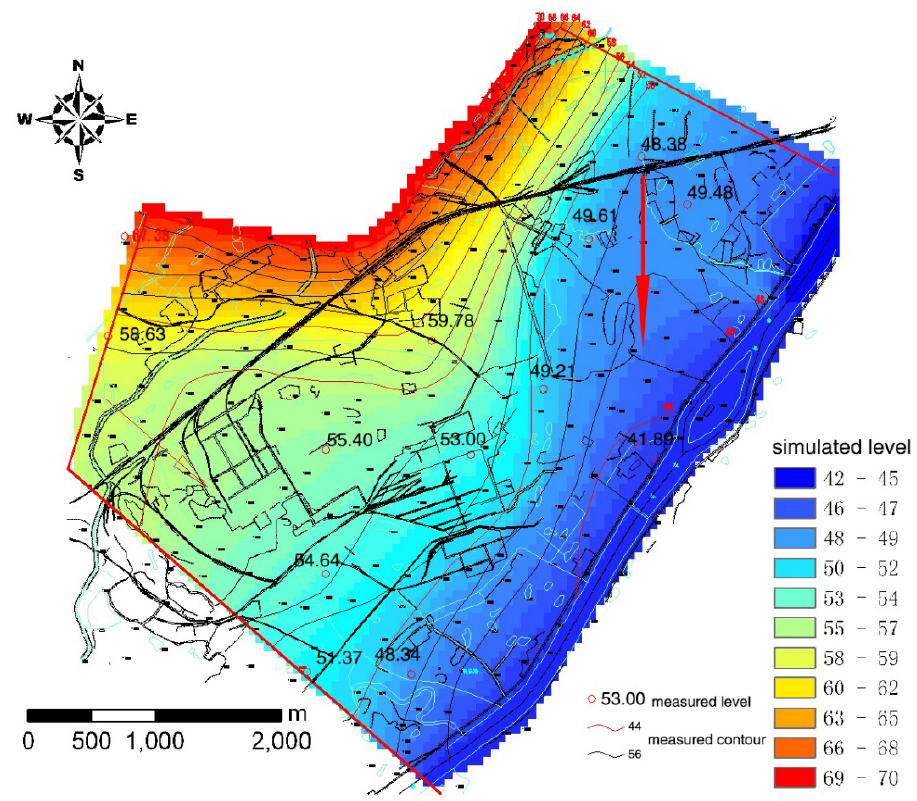
Figure 6. Comparison of the simulated groundwater contour with the head surveyed in a real well.